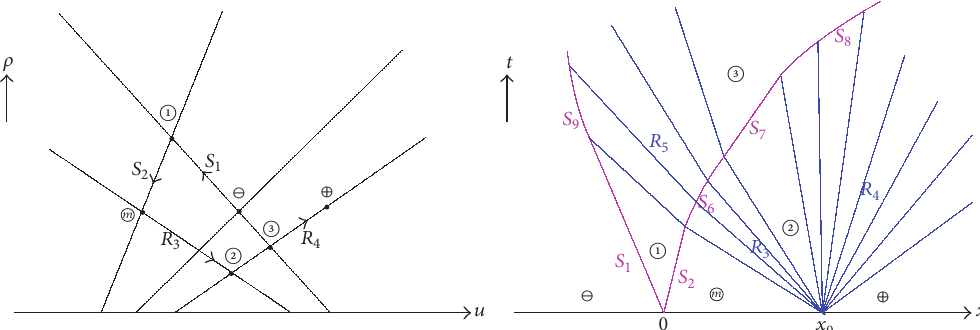
Figure 8: The interaction between 𝑆 + 𝑆 and 𝑅 + 𝑅 is shown when (𝑢 + , 𝜌 + ) ∈ 𝑉 8